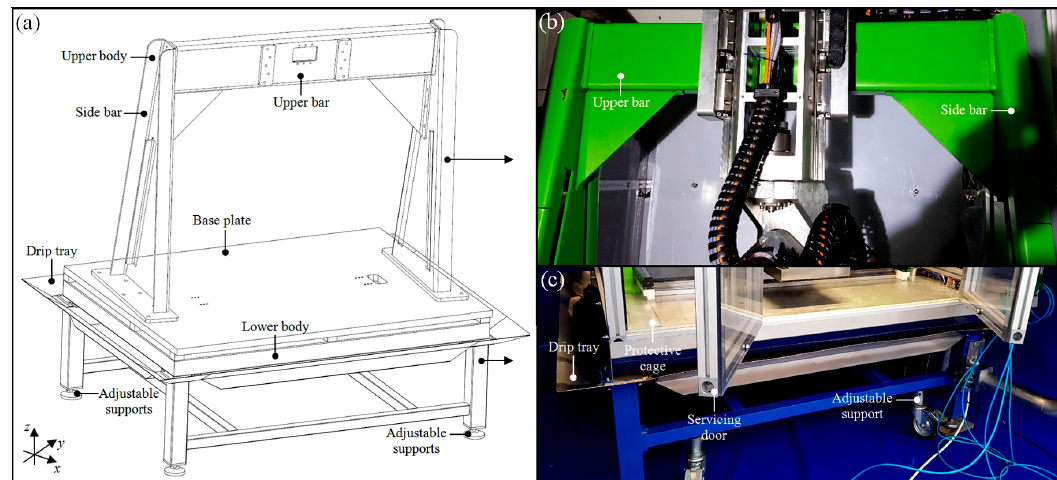
Figure 2. Construction phase of a 5-axis CNC grinding machine for the precision grinding process of the cutting edges of industrial cutting blades: ( a ) Axonometric view of the three-dimensional (3D) model of the upper and lower body; ( b ) the upper body with mounted auxiliary bodies; ( c ) construction details of the lower